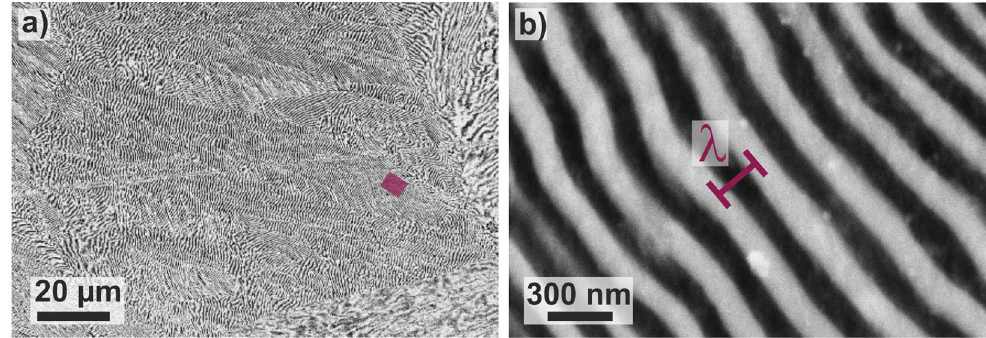
Figure 2. Eutectic microstructure of flash-annealed Al 82.7 Cu 17.3 -specimens. Five independent samples were molten and quenched in water for microstructural investigations. ( a ) SEM-image shows multiple eutectic domains. ( b ) The high-magnification SEM micrograph depicts a eutectic island in which the interlamellar spacing, λ , is marked. The magnified area is marked with a purple rectangular in ( a